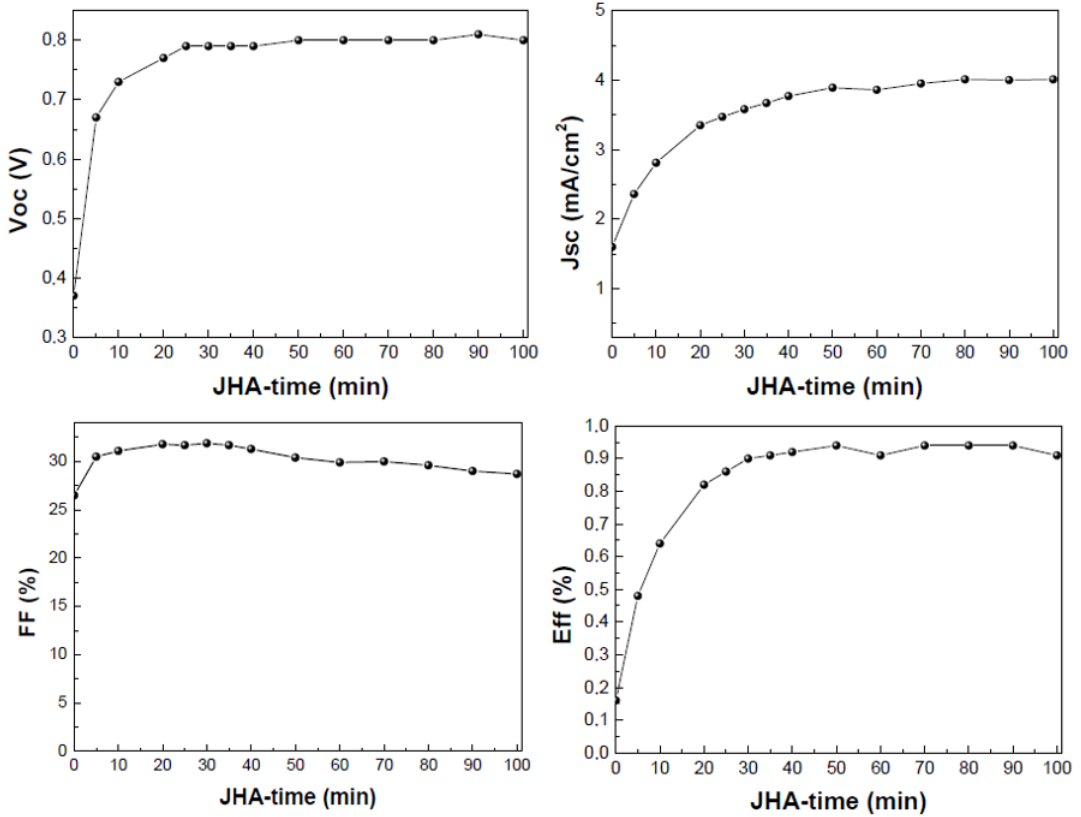
Figure 4. V oc , J sc , FF, and efficiency parameters versus exposure time to JHA-treated devices onto flexible